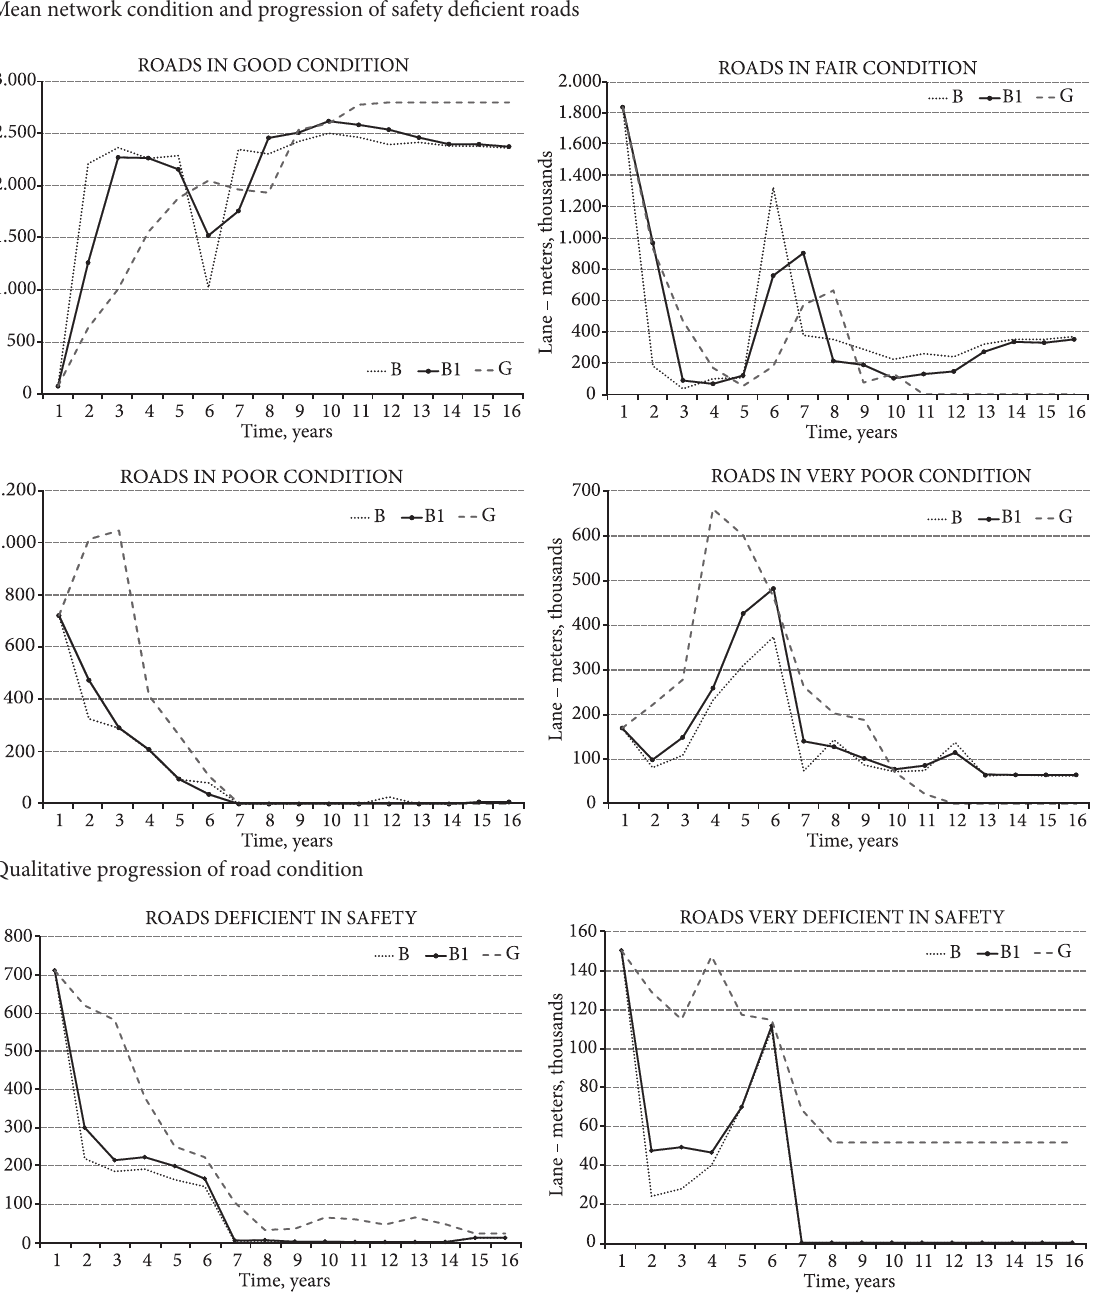
fig. 3. Mean network condition and progression of safety deficient roads